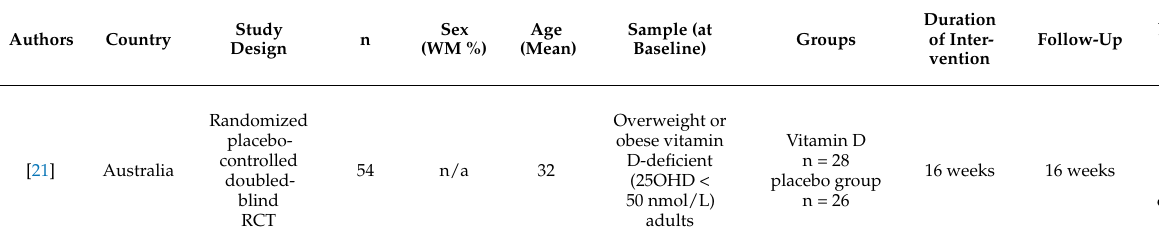
Table 2. Characteristics of included randomized controlled trials with Vitamin D and Calcium